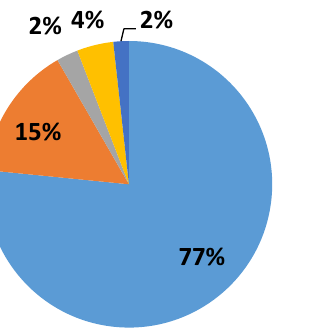
Figure 8. Sharing of electricity consumption among the components.